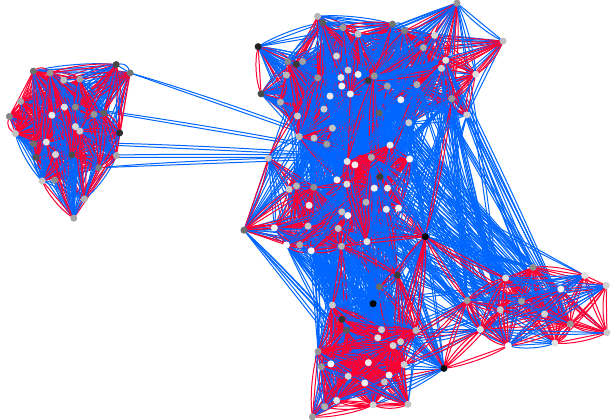
FIG. 2. Visualization of CN G . For clarity, only the nodes 1 with strengths larger than 100 and the links among them are drawn. The darkness of the node color represents the value of I i ; a darker node has a larger I i . The thickness of the link is proportional to its weight. The links with weights larger than or equal to (smaller than) the median value (i.e., 5) are indicated by red (blue)